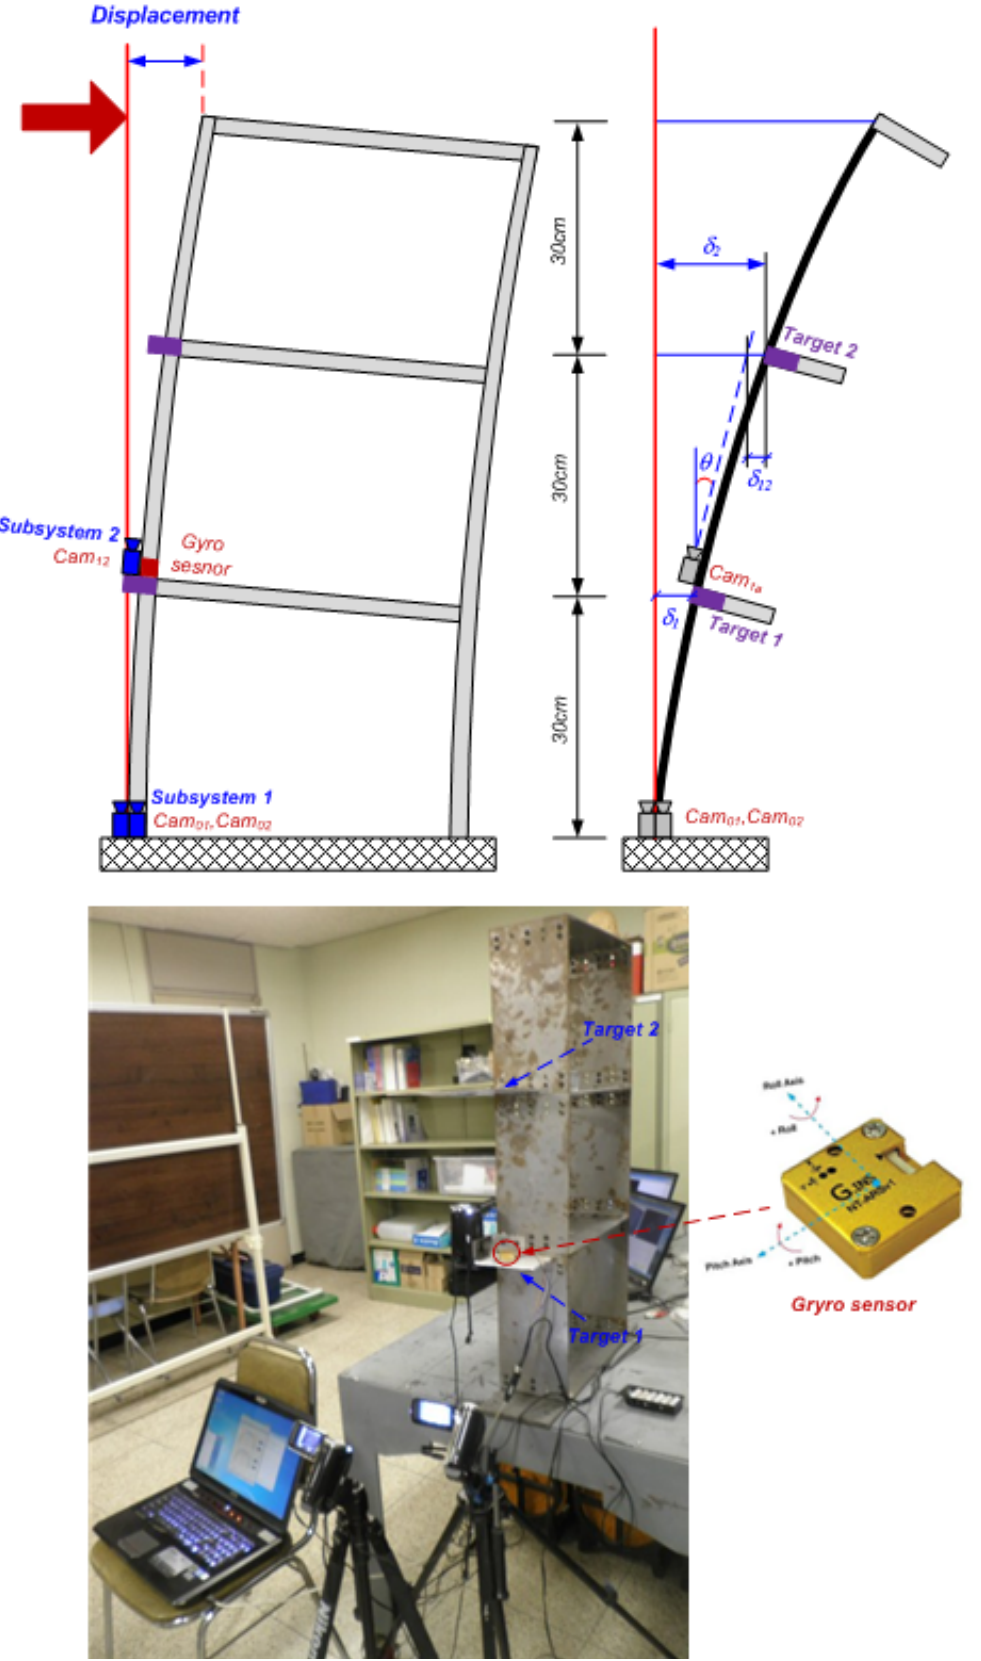
Figure 3. Experimental